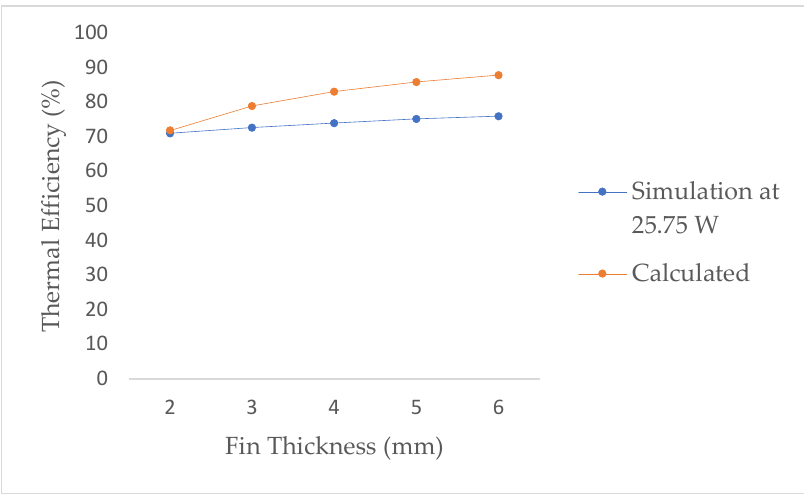
Figure 12. Comparison between simulation and calculated efficiency.